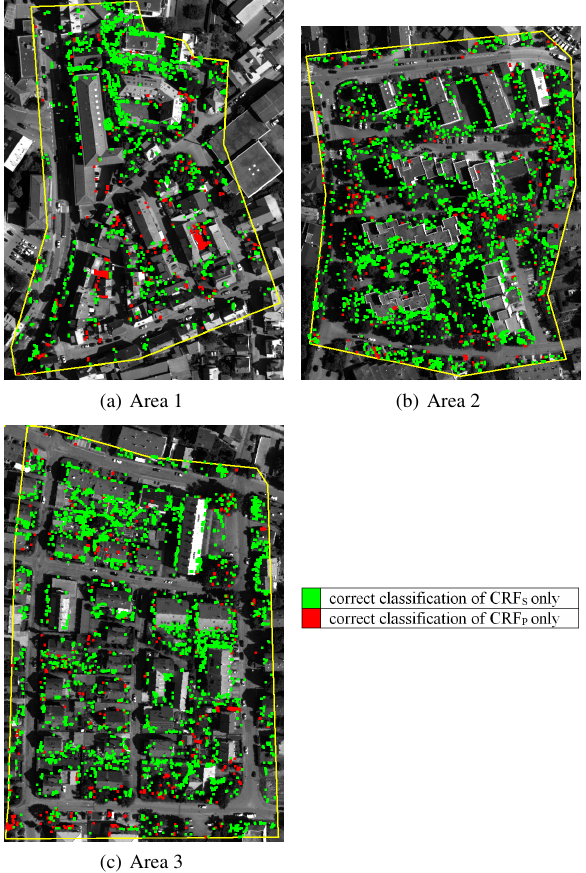
Figure 2. Point-wise comparison of the results obtained by CRF S and CRF P